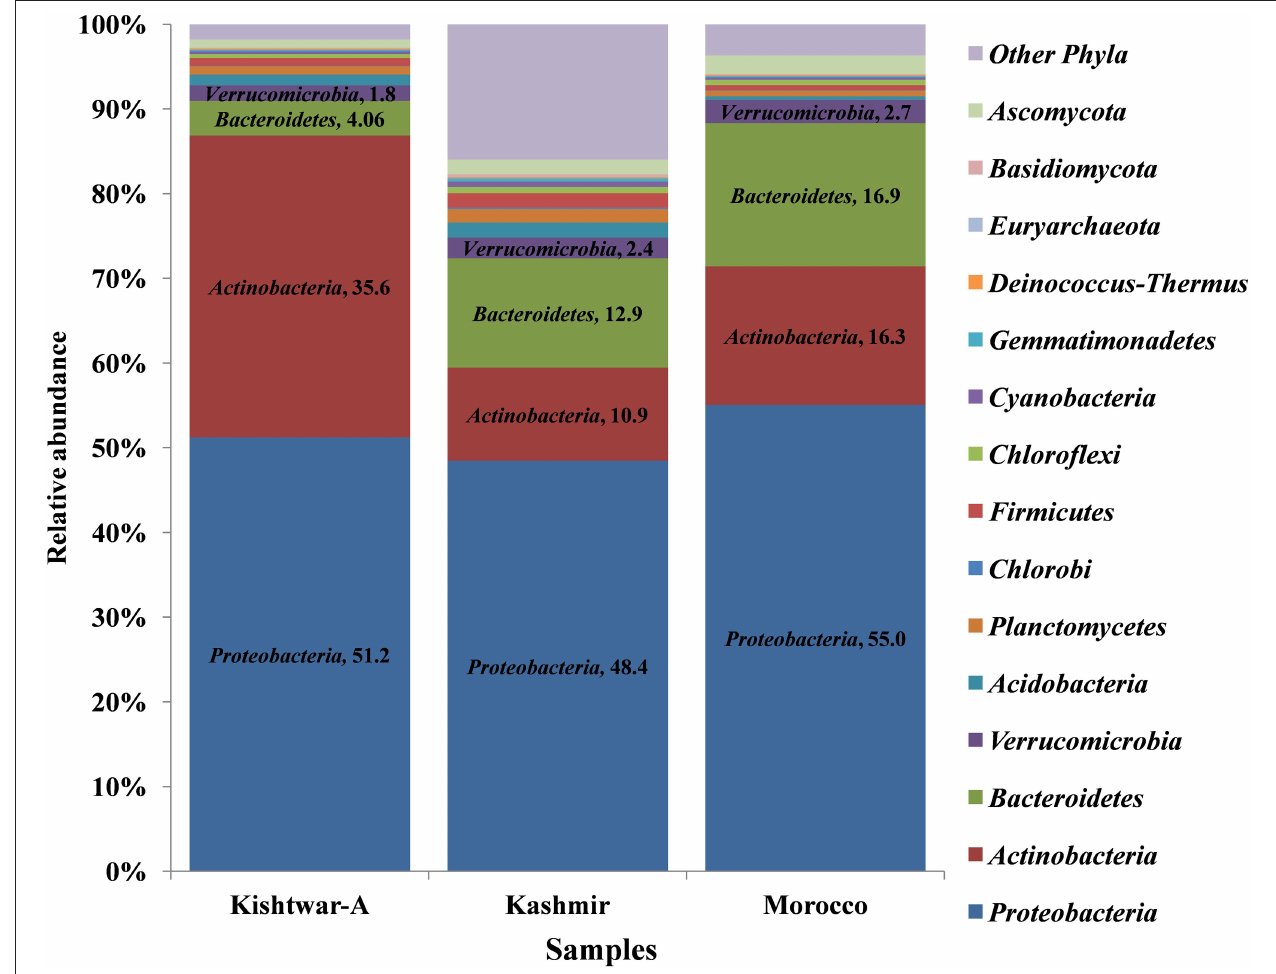
FIGURE 8 | Representation of relative abundance of different phyla in all the three geographical locations (Kishtwar-A, Kashmir, and Morocco). Fifteen major phyla (12 bacterial, 2 fungal, 1 archaeal) were cataloged from the cormosphere of saffron grown in three geographical locations. Proteobacteria was dominant in all the three locations followed by Actinobacteria and Bacteroidetes in Kishtwar-A and Bacteroidetes and Actinobacteria in both Kashmir and